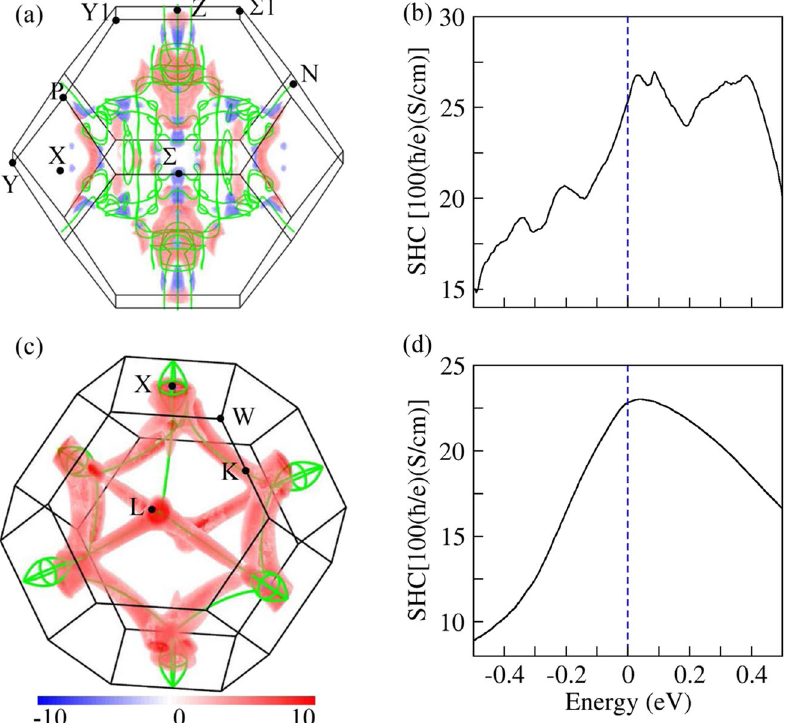
Fig. 3 Microscopic analysis for selected materials. SBC and nodal line distributions for ( a ) In 5 Bi 3 with point group 4/ mmm , and ( c ) Pt with point group m 3 m , respectively. The green lines represent nodal lines. The color bar is in arbitrary units. Fermi-level-dependent SHC for ( b ) In 5 Bi 3 and ( d ) Pt,